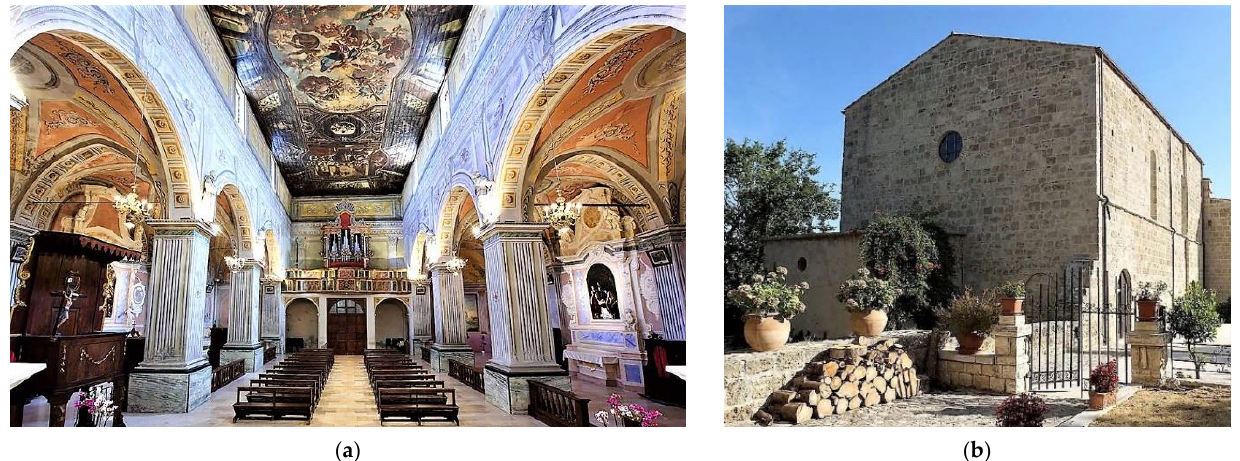
Figure 2. Two examples of surveyed churches: ( a ) Holy Mary in Platea in Campli, Teramo (XV Cen.); ( b ) Abbey of Holy Mary in Montesanto in Teramo (X – XI Cen.).